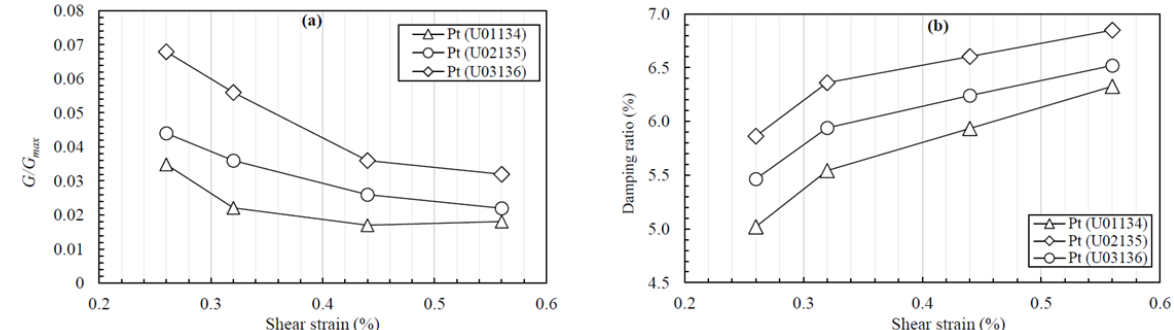
Figure 7. Dynamic parameters of Agartala peat :- (a) Variation of secant shear modulas ( G/G max ) with respect to shear strain range of 0.26 to 0.55 %. (b) Damping ratio (%) within strain range 0.26 to 0.55 %.